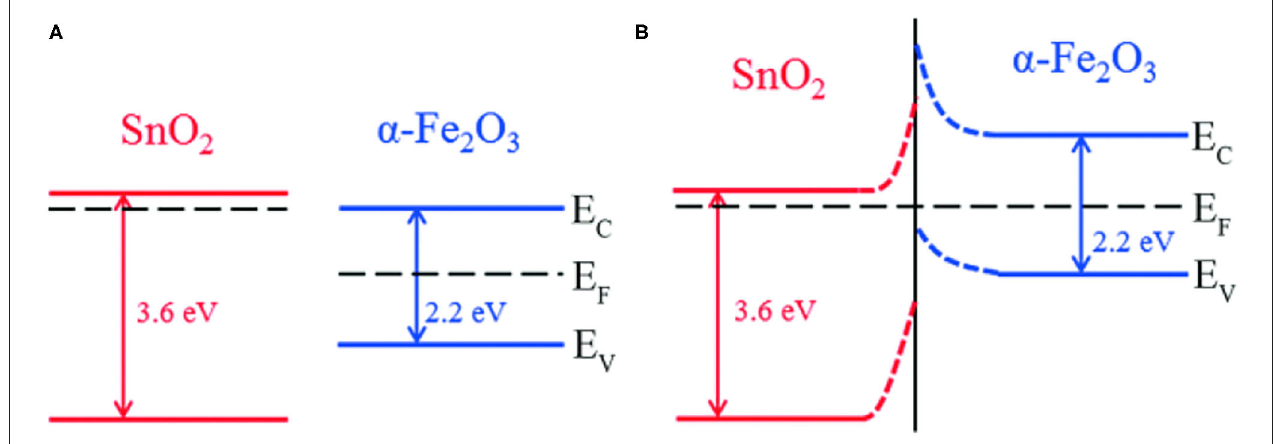
FIGURE 2 | (A) Schematic diagram of the energy band structures for SnO 2 and α -Fe 2 O 3 . (B) The energy band of SnO 2 @ α -Fe 2 O 3 heterostructures. E C , E F , and E V stand for conduction band energy, Fermi energy, and valence band energy, respectively. Reproduced from Cui et al.